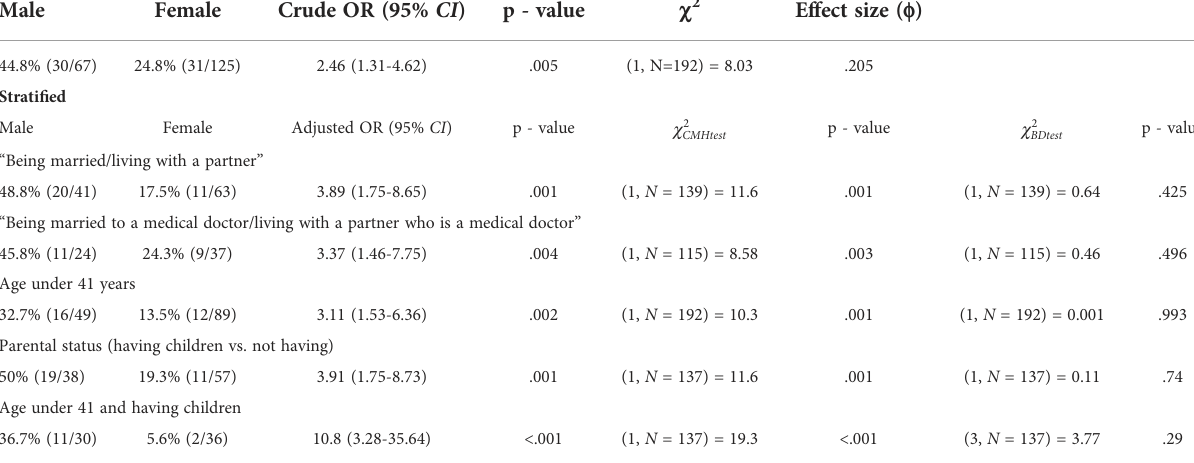
TABLE 3 Leadership position analysis.